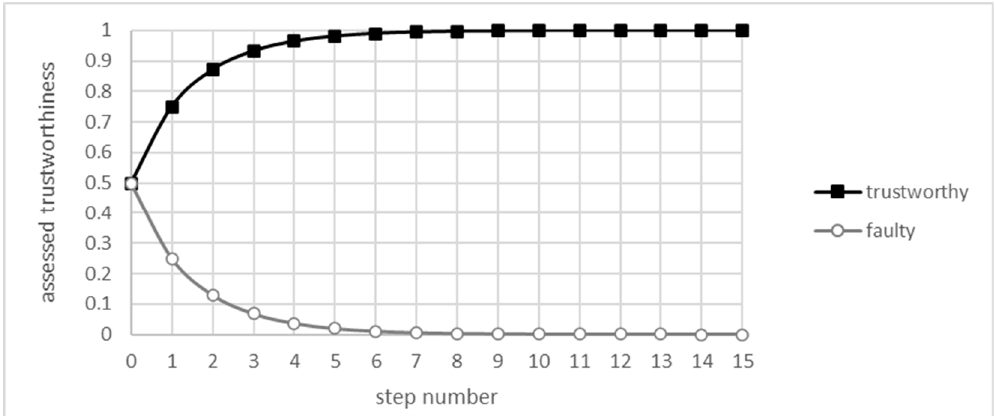
Figure 3. First steps of the algorithm for the UOG.